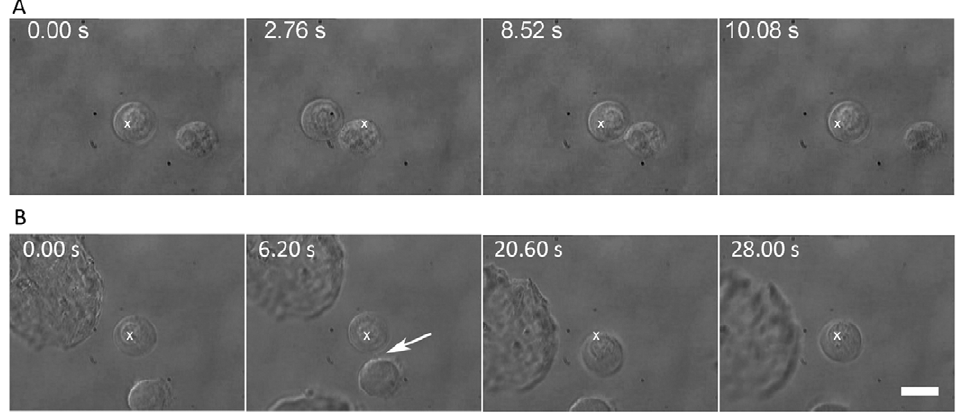
Figure 12. Time-lapse images from real-time movies depicting the outcome of a 1-hour treatment of NSCs with EGTA, a calcium ion chelator. A) absence of membrane-mediated adhesion between the two EGTA-treated NSCs brought into close contact for , 6 s (data extracted from Movie S6); B) filopodial contact between the two EGTA-treated NSCs results in adhesion at , 5 s. Subsequently, the NSCs remain adhered when the trap focus is moved slightly, but they are eventually pulled apart , 8 s later. The scale bar denotes 10 m m. doi:10.1371/journal.pone.0038613.g012 filopodial length measurements in their fibroblast cell line.